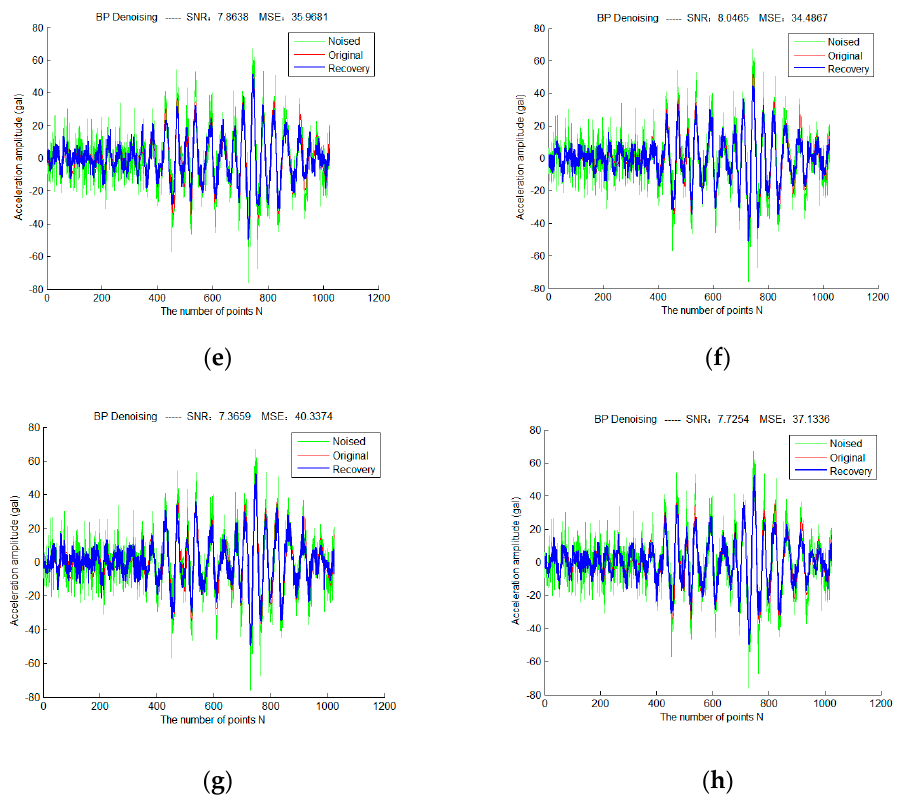
Figure 9. The Compressive Sensing Denoising Experiment of a Frame of Strong Earthquake Signals Based on Different Sampling Matrices ( a ) is the original and noise-adding waveforms of the frame signal in the time and frequency domain(sigma = 2); ( b ) is the result based on FIR filtering; ( c ) is the result based on Butterworth filtering; ( d ) is the result based on Chebyshev filtering; ( e ) is the BPDN compressive sensing denoising result based on the Gauss sampling matrix; ( f ) is the BPDN compressive sensing denoising result based on the Bernoulli sampling matrix; ( g ) is the BPDN compressive sensing denoising result based on the PartHadamard sampling matrix;( h ) is the BPDN compressive sensing denoising result based on the SparseRandom sampling matrix.